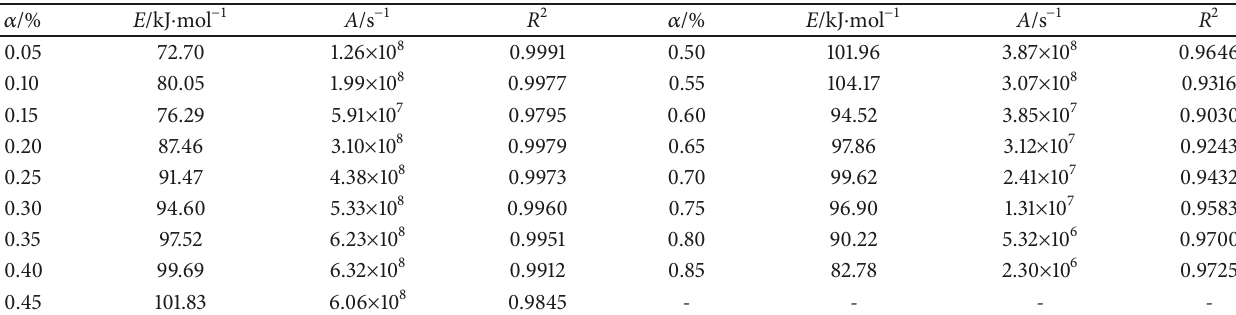
Table 4: Combustion kinetic parameters of wood powders under different conversion